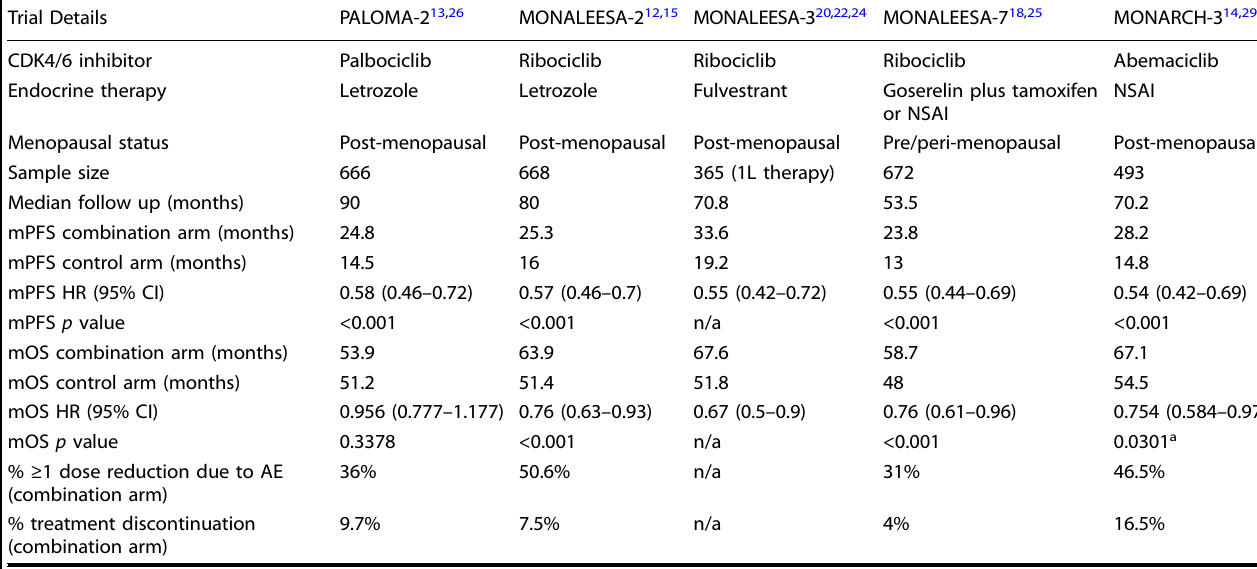
Table 1. Results from pivotal prospective randomized controlled trials investigating palbociclib, ribociclib and abemaciclib combined with an endocrine partner in the treatment of fi rst-line patients with HR +